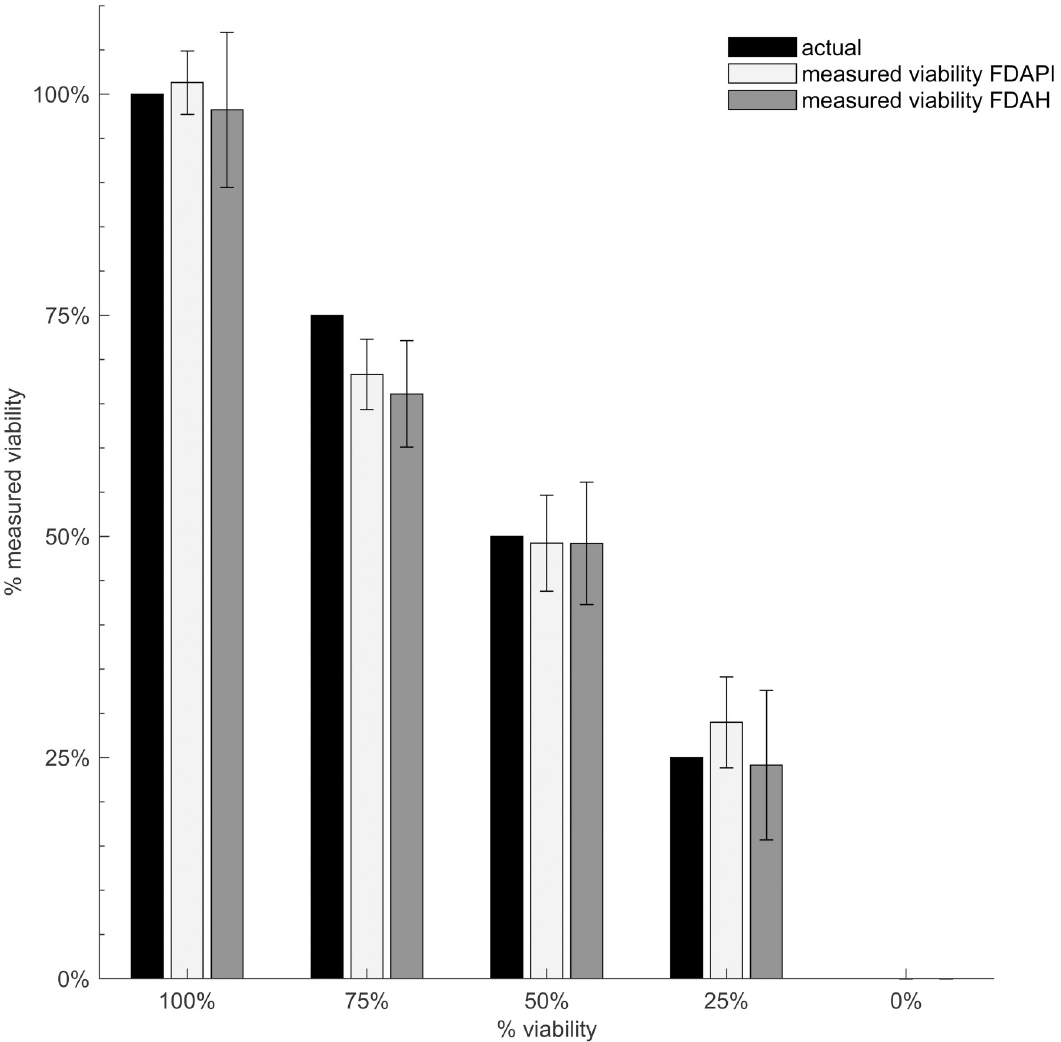
SEM of nine wells (experiments run in triplicate and repeated three times). “Actual” viabilities are the known proportions of live and dead cercariae in each well, and “measured” viabilities are those quantified with the fluorescence